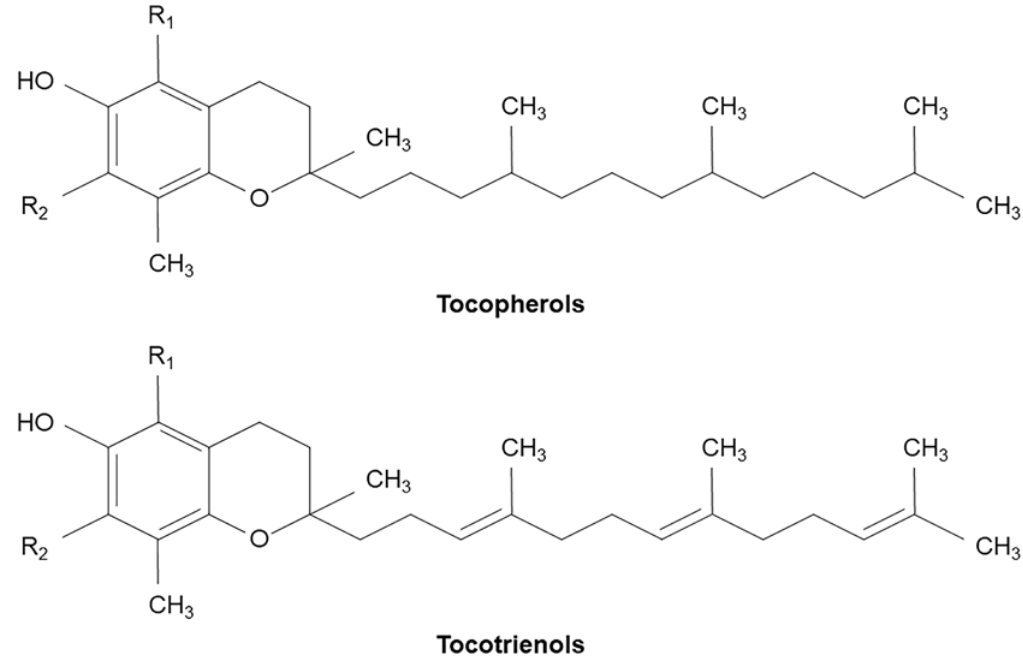
Figure 1. Molecular structure of tocopherols and tocotrienols.